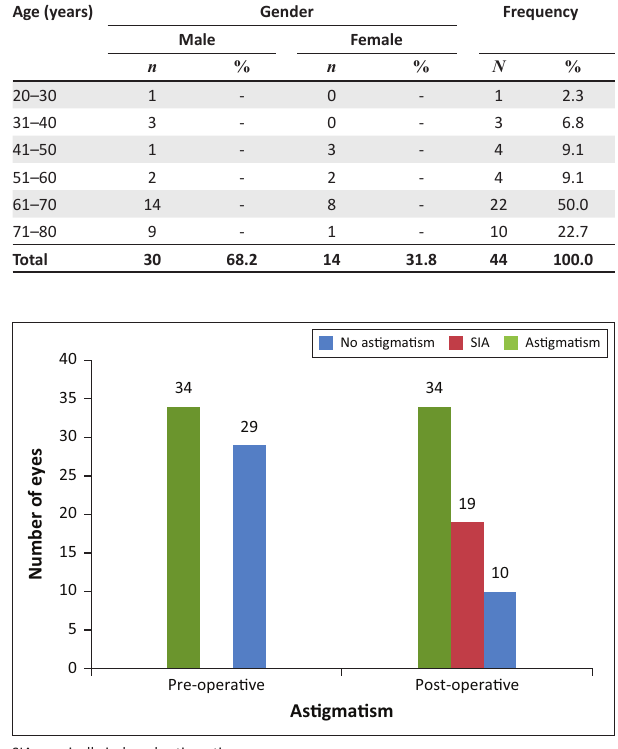
TABLE 1: Demographic variables of patients.